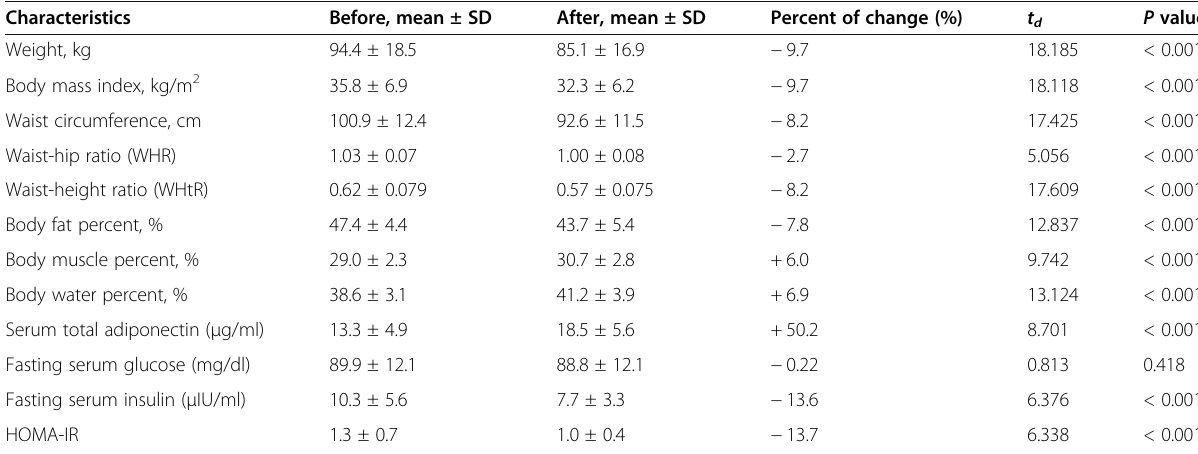
Table 1 Anthropometric and laboratory characteristics of the sample of overweight and obese women before and after the intervention ( n = 95), Alexandria, Egypt,